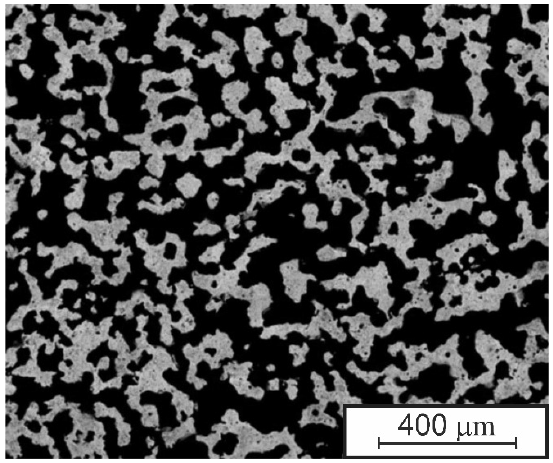
Figure 2. Macrostructure of the porous TiNiСu 6 .